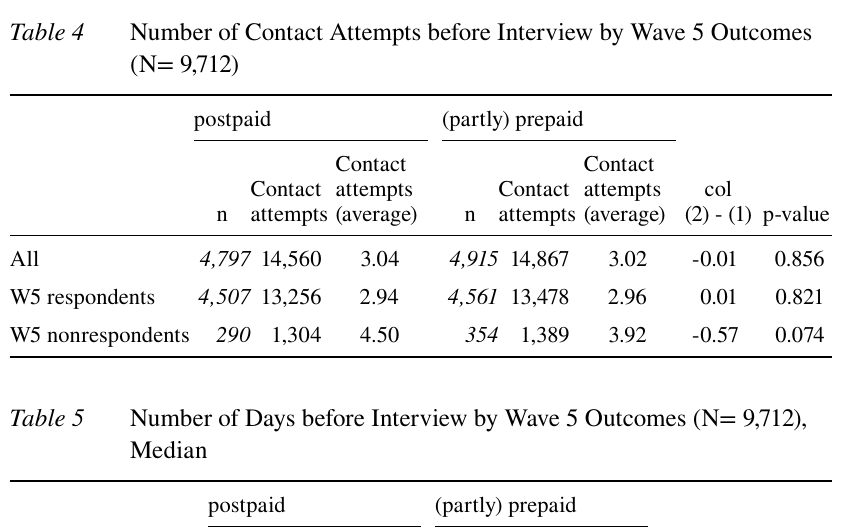
Number of Days before Interview by Wave 5 Outcomes (N= 9,712), Median postpaid (partly) prepaid n median n median col (2) - (1)